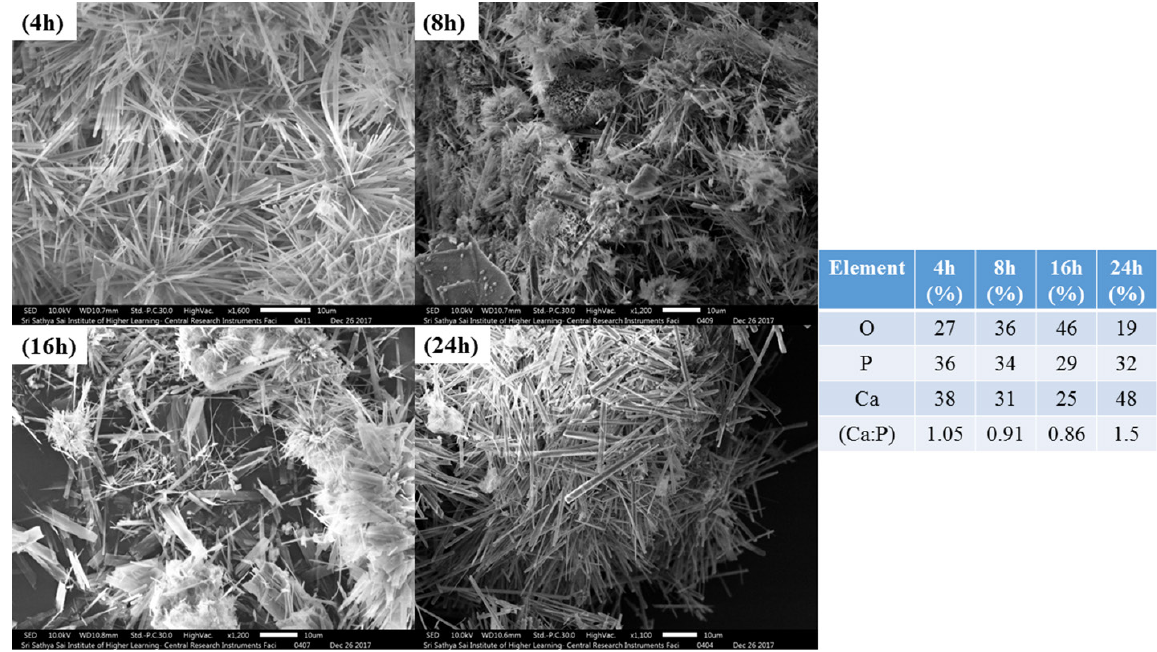
Figure 2: SEM images and the corresponding EDX report of the composition of the Nano-crystalline hydroxyapatite for the various dwell times in hydrothermal synthesis at 10 µ m